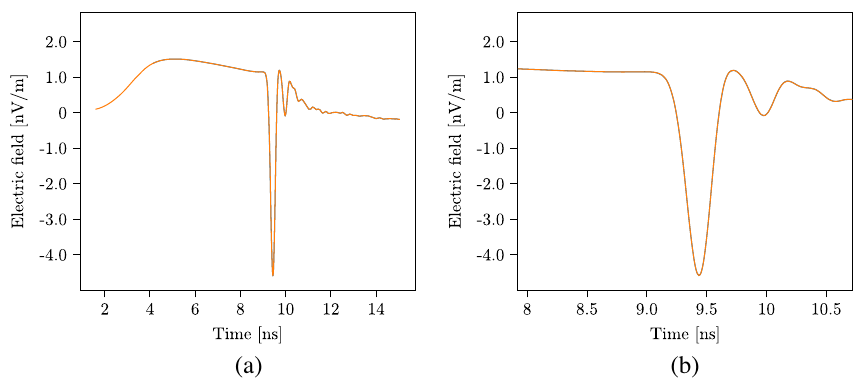
⃗ E component at the broadband monitor of the model shown in Fig. 15(b) for 100 ps z